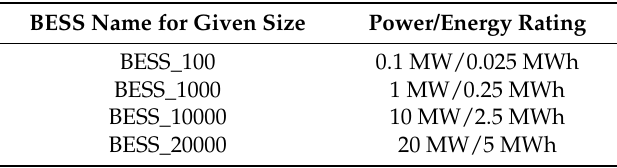
Table 2. Proposed initial BESS size